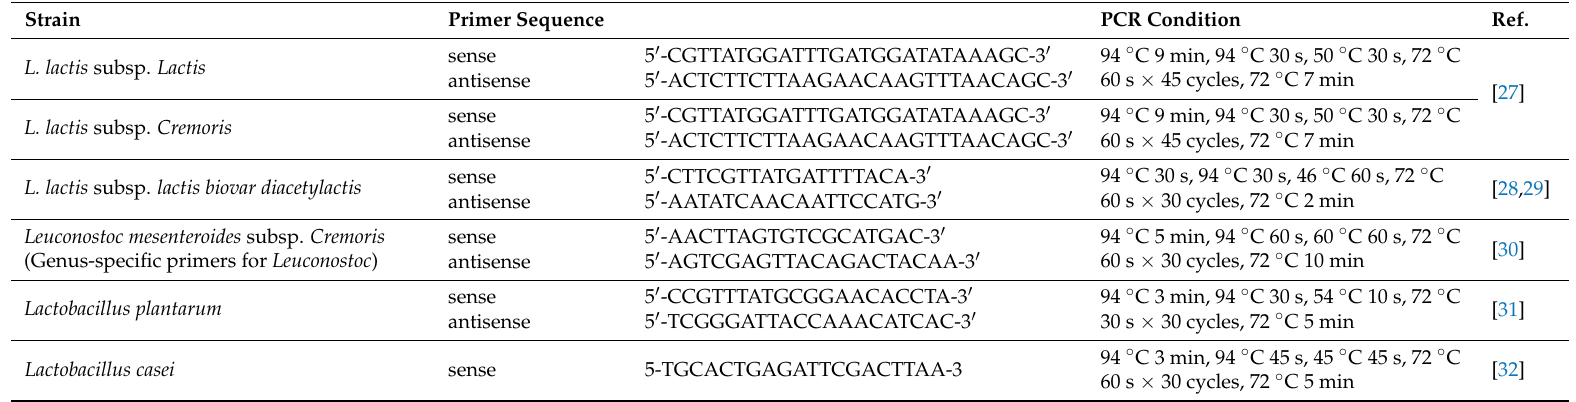
Table 1. Polymerase chain reaction (PCR) primers and reacting